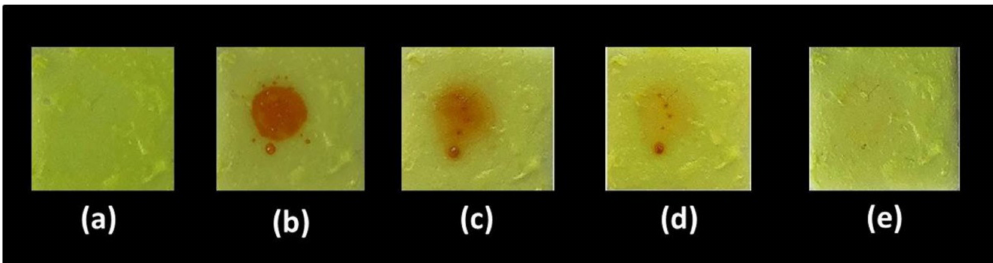
Figure 7. ( a – e ) Photographs of the fluorescence quenching and recovery of n-TPE-AP-PDMS film to NB liquid at different times in natural